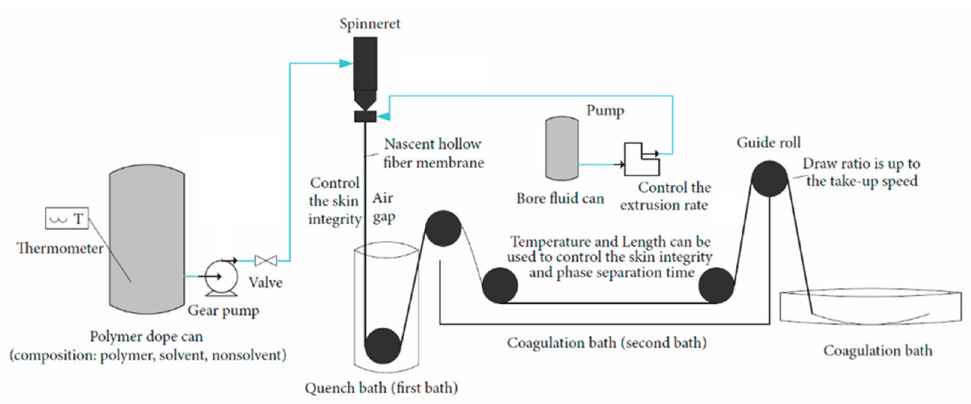
Figure 6. Scheme of the hollow fiber dry-wet spinning machine (reproduced with permission from [31]).